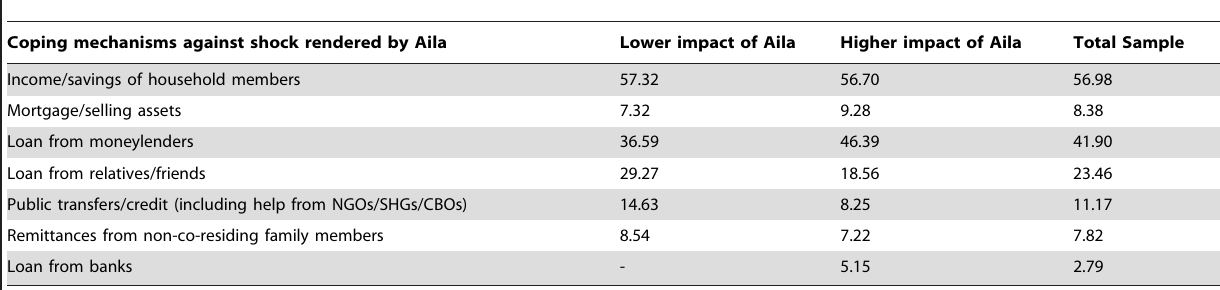
Table 1. Average proportion of households employing alternative coping strategies in response to climatic shock caused by cyclone Aila , Sundarbans, West Bengal, India.